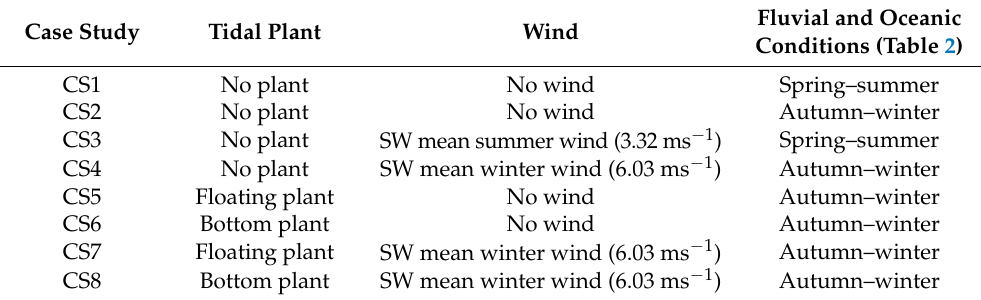
Table 4. Summary of boundary conditions and the situations simulated in the different case studies